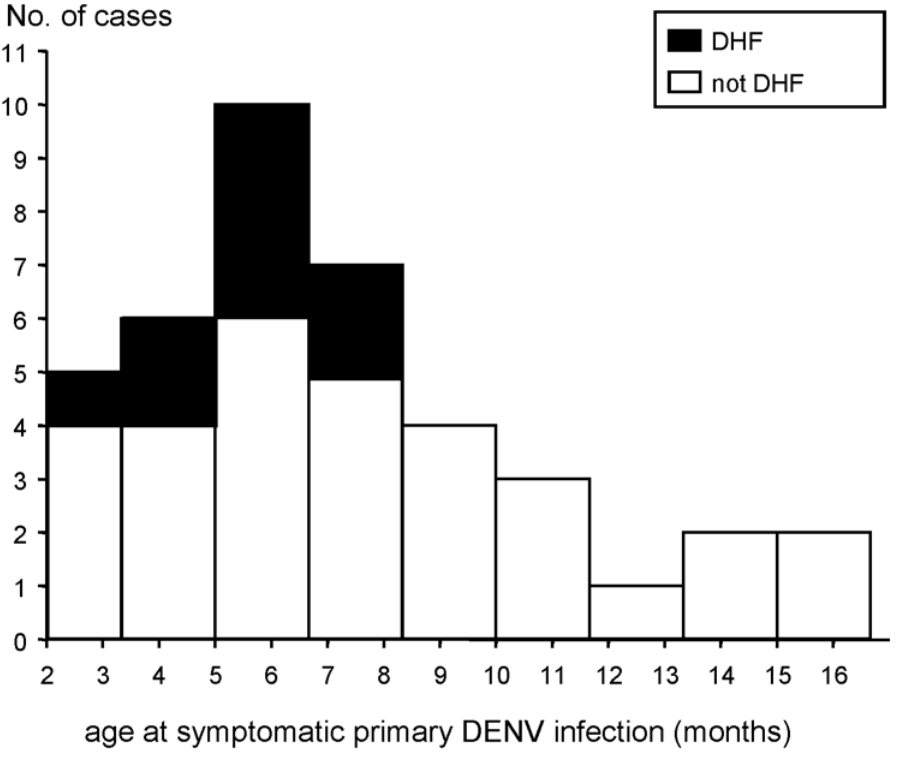
Figure 2. Age distribution of infants with symptomatic primary DENV infections. Filled bars, hospitalized infants with DHF. Open bars, hospitalized and nonhospitalized infants without DHF.